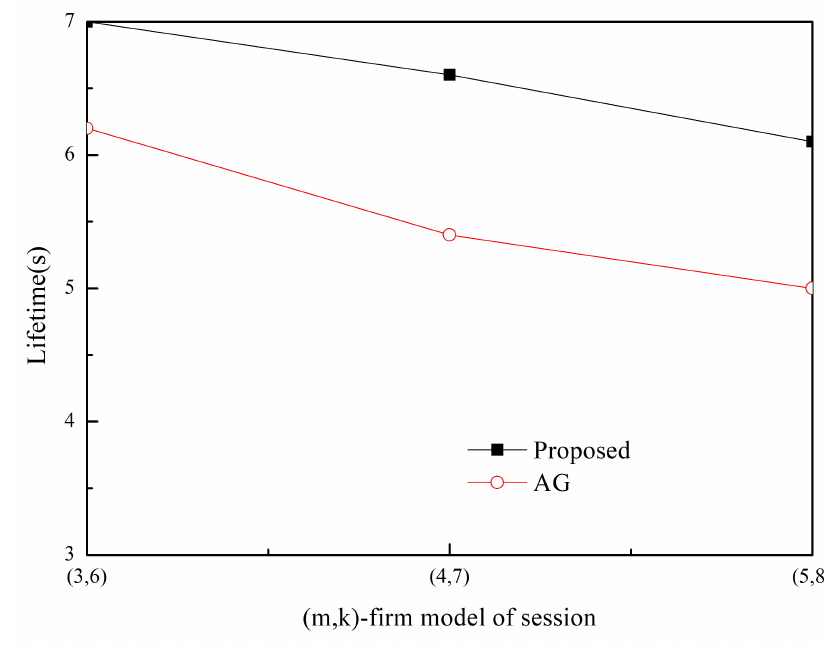
Figure 10. Lifetime in (2,5)-firm application as a function of ( m , k )-firm sets.